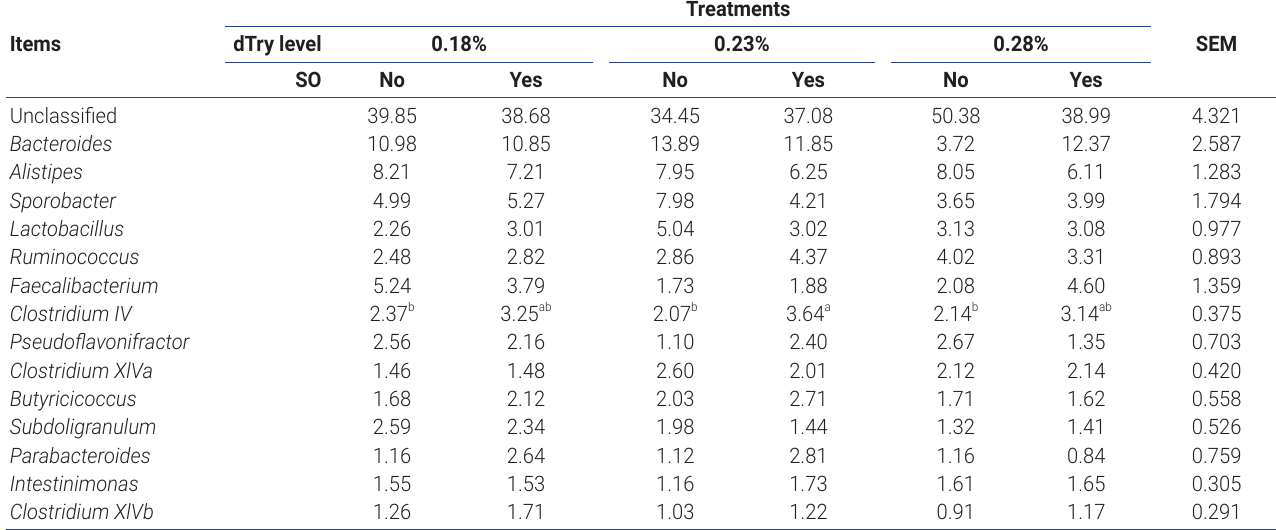
Table 5. i) Effects of dietary digestible tryptophan and soy oligossacharide supplementation on caecal microbial relative abundances in broiler chickens (at genus level)